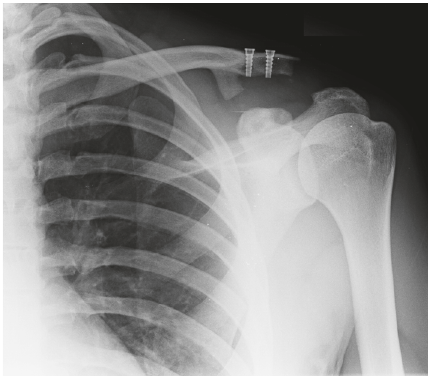
Figure 2: Anteroposterior left ACJ radiograph at three months after LARS July 2016 implantation demonstrating relapse of ACJ dislo- cation and heterotopic ossification medial to the medial clavicular screw.